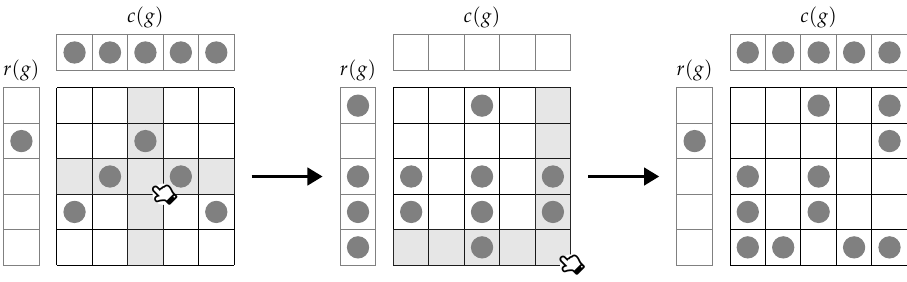
Figure 8. Both the row and column parity vectors are flipped after performing a